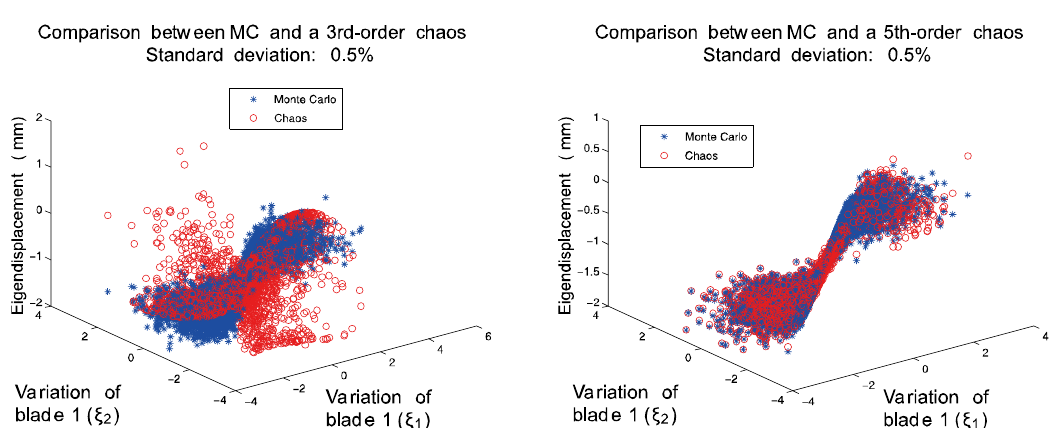
Fig. 5. Response surface of the eigenvectors – Effect of the polynomial chaos